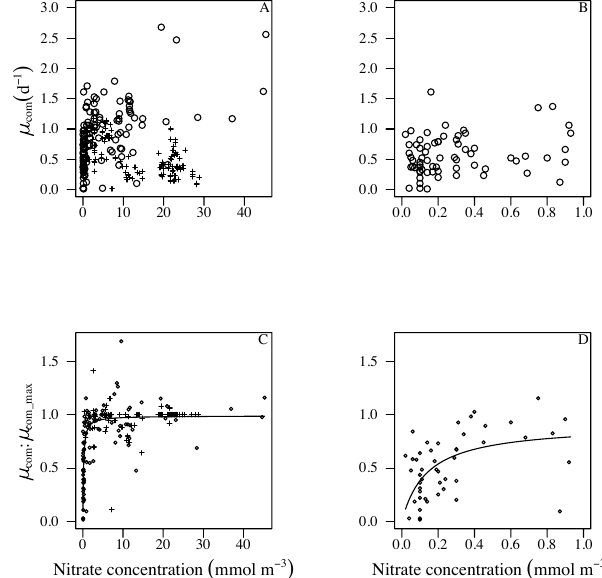
Figure 3. Relationships between in situ community growth rate ( µ com , d − 1 ) and nutrient concentration (a) from 0 to 40mmolm − 3 and (b) from 0 to 1mmolm − 3 . Relationships between in situ µ com : µ com_max ratio and nutrient concentration (c) from 0 to 40mmolm − 3 and (d) from 0 to 1mmolm − 3 . Crosses represent phytoplankton communities of Table A1 sampled in HNLC regions and circles represent the rest of the phytoplankton communities from Table A1 data set. (c, d) The solid lines represent the non- linear least square fits for the global data set (HNLC